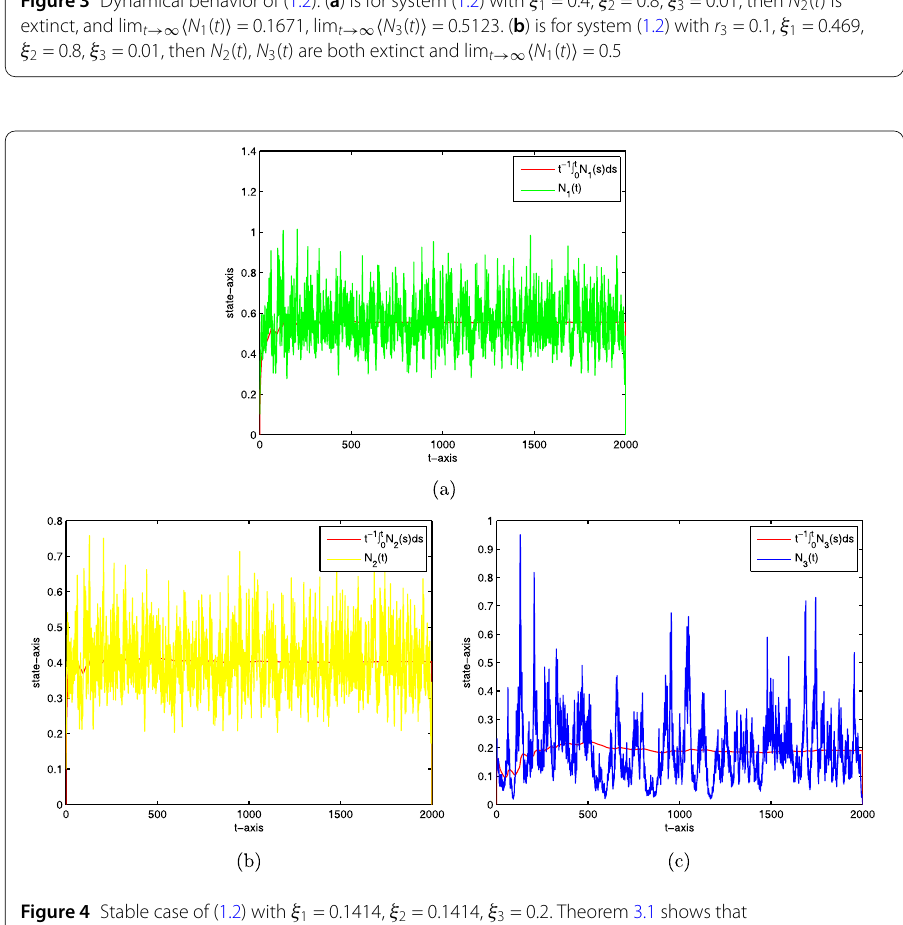
Figure 4 Stable case of (1.2) with ξ 1 = 0.1414, ξ 2 = 0.1414, ξ 3 = 0.2. Theorem 3.1 shows